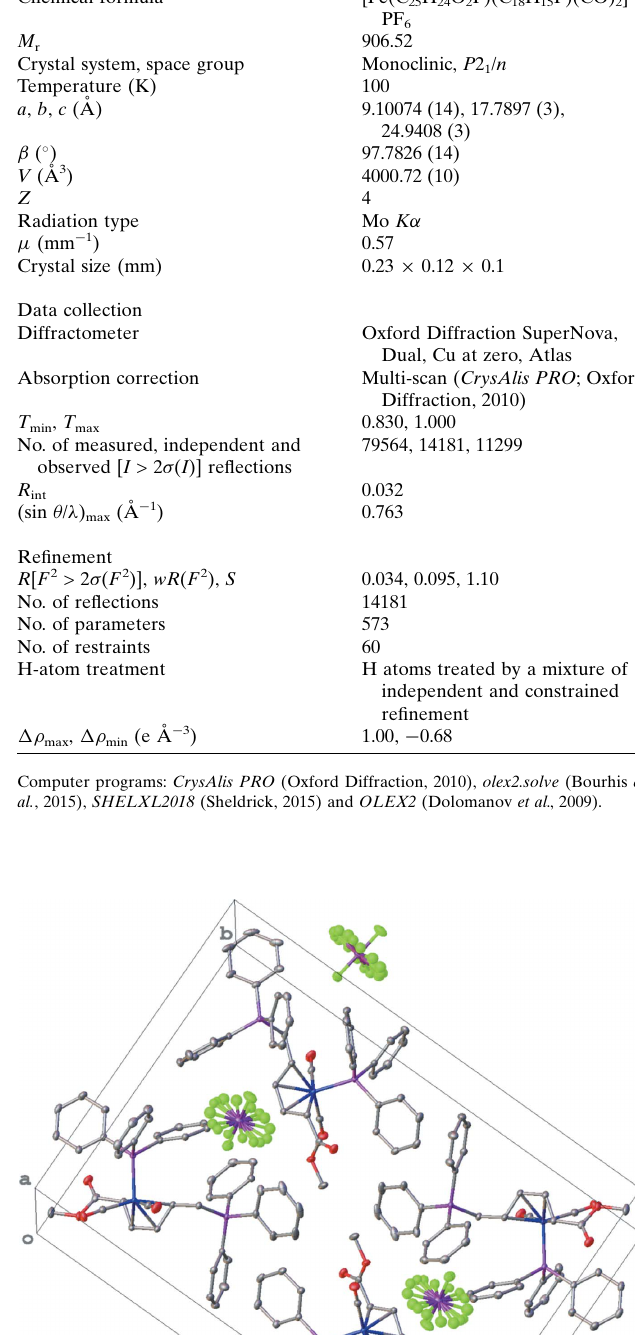
Table 2 Experimental details. Crystal data Chemical formula